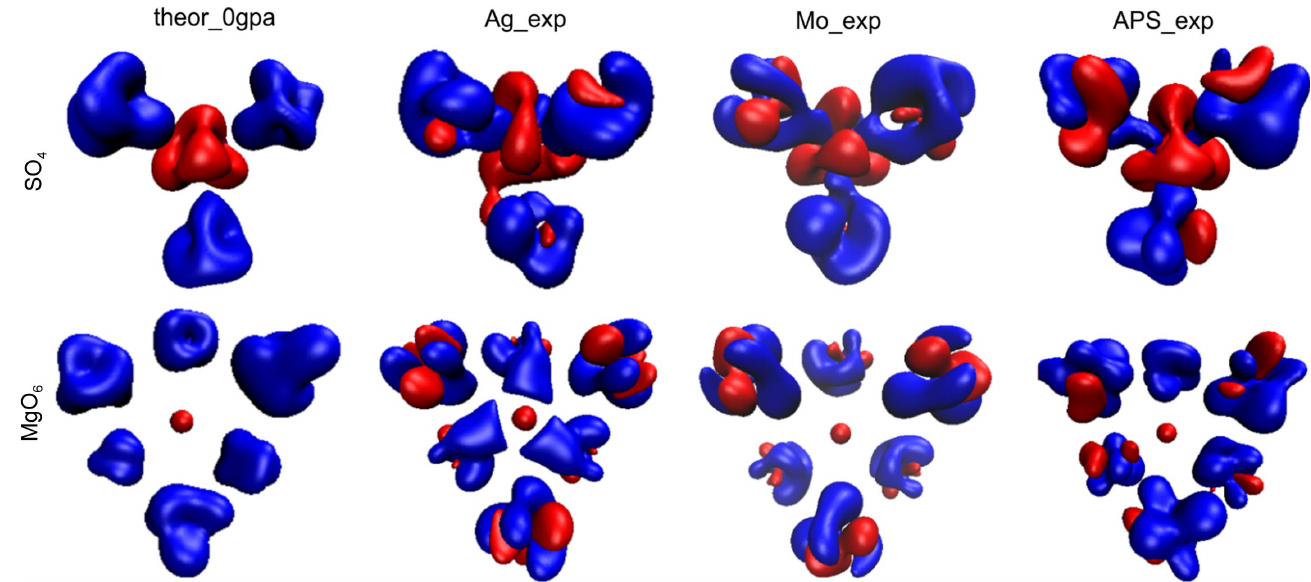
Figure 6 3D deformation density maps (red – minus values, blue – plus values, contour (cid:5) 0.022 e).